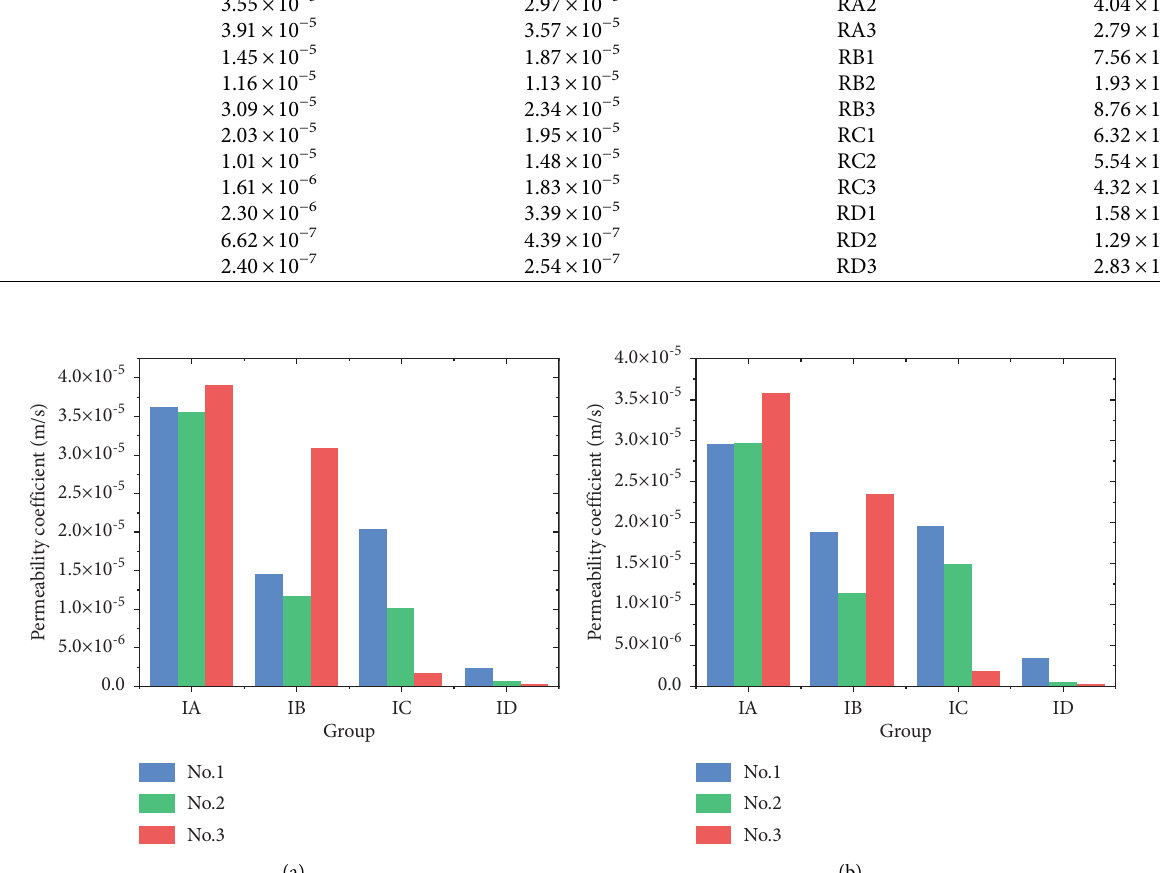
Figure 5: Permeability coefficient of intact loess. (a) The vertical permeability coefficient. (b) The horizontal permeability coefficient.